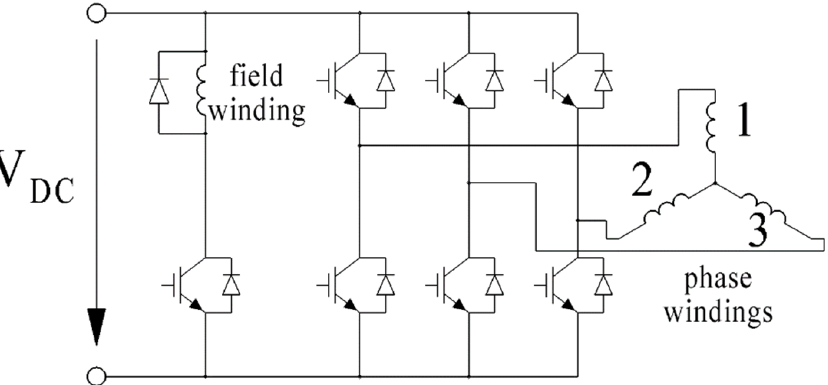
Figure 2. Schematics of the three-phase inverter with a DC-chopper for the excitation